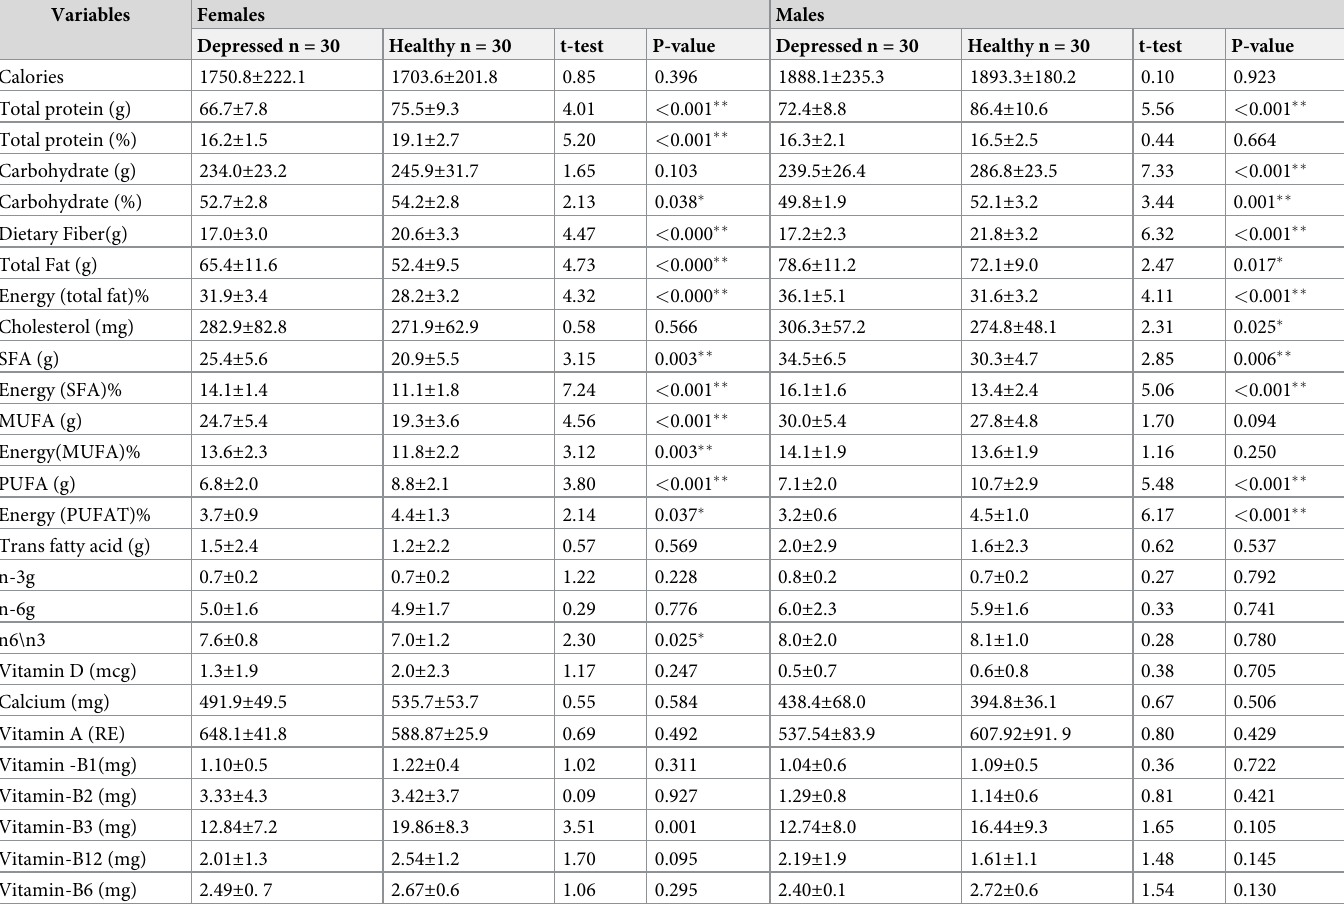
Table 2. Daily nutrients intake of depressed and healthy females and males